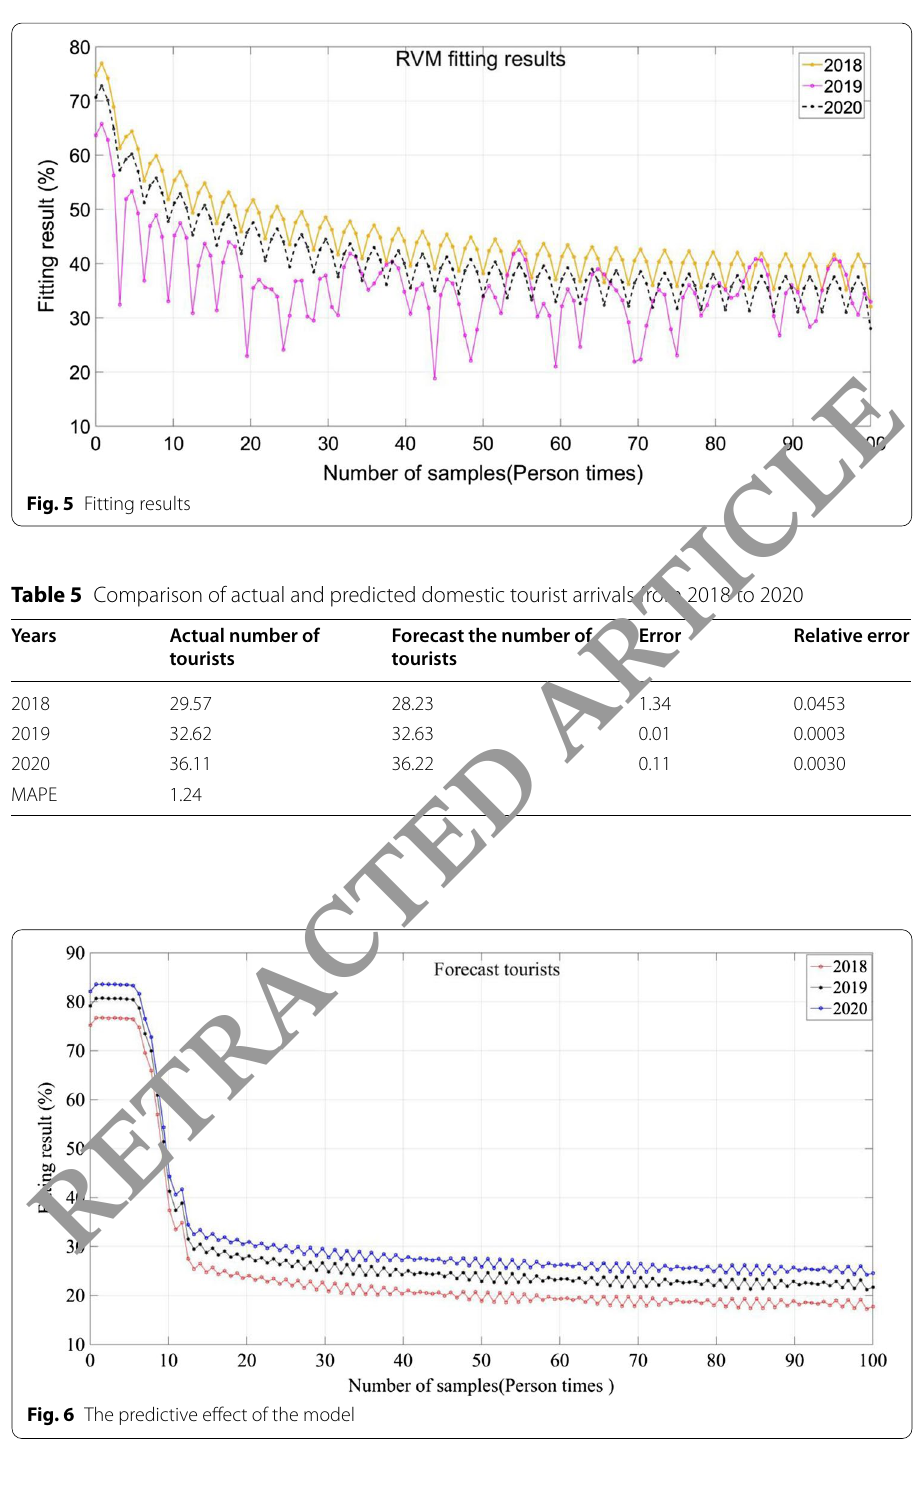
Fig. 6 The predictive effect of the